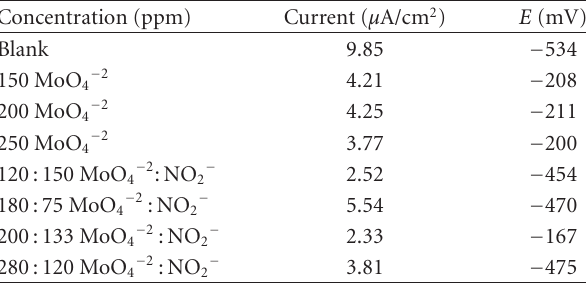
200 : 133 ppm MoO 4 : NO 2 . The electrochemical behaviour of the proportion 1.5 to 1 for MoO 4 and NO 2 , respectively, was studied varying their